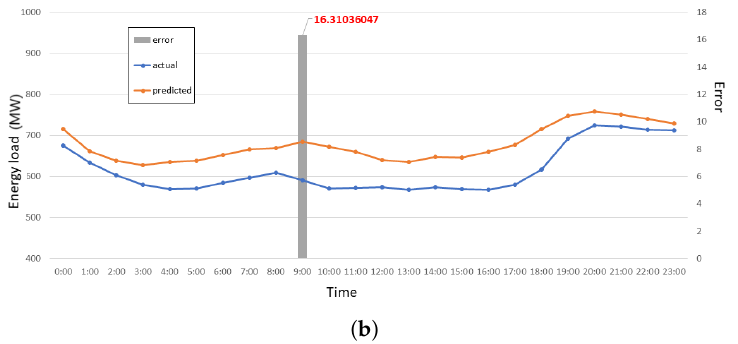
Figure 15. Highest errors recorded due to lunar new year. ( a ) First holiday of lunar new year; ( b ) Second holiday of lunar new year.